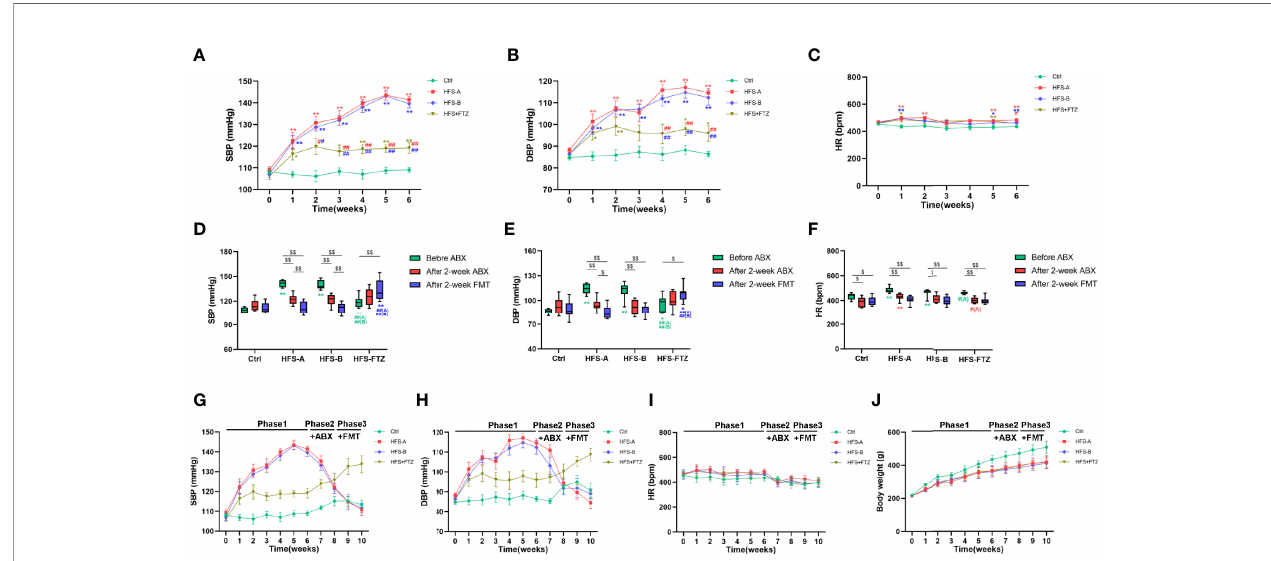
FIGURE 6 | Transplantation with FTZ-modulated gut microbiota decreased the blood pressure in HFS-fed rats. (A) SBP before ABX intervention. (B) DBP before ABX intervention. (C) HR before ABX intervention. (D) SBP after ABX and FMT interventions. (E) DBP after ABX and FMT interventions. (F) HR after ABX and FMT interventions. (G) SBP in these three phases. (H) DBP in these three phases. (I) HR in these three phases. (J) Body weight in these three phases. ∗ p < 0.05, ∗∗ p < 0.01 vs. Ctrl; # p < 0.05, ## p < 0.01 vs. HFS-A/B; $ p < 0.05, $$ p < 0.01. n = 8 per group. FTZ, Fufang-Zhenzhu-Tiaozhi capsule; HFS, high fructose and high salt; SBP, systolic blood pressure; ABX, antibiotics; DBP, diastolic blood pressure; HR, heart rate; FMT, fecal microbiota